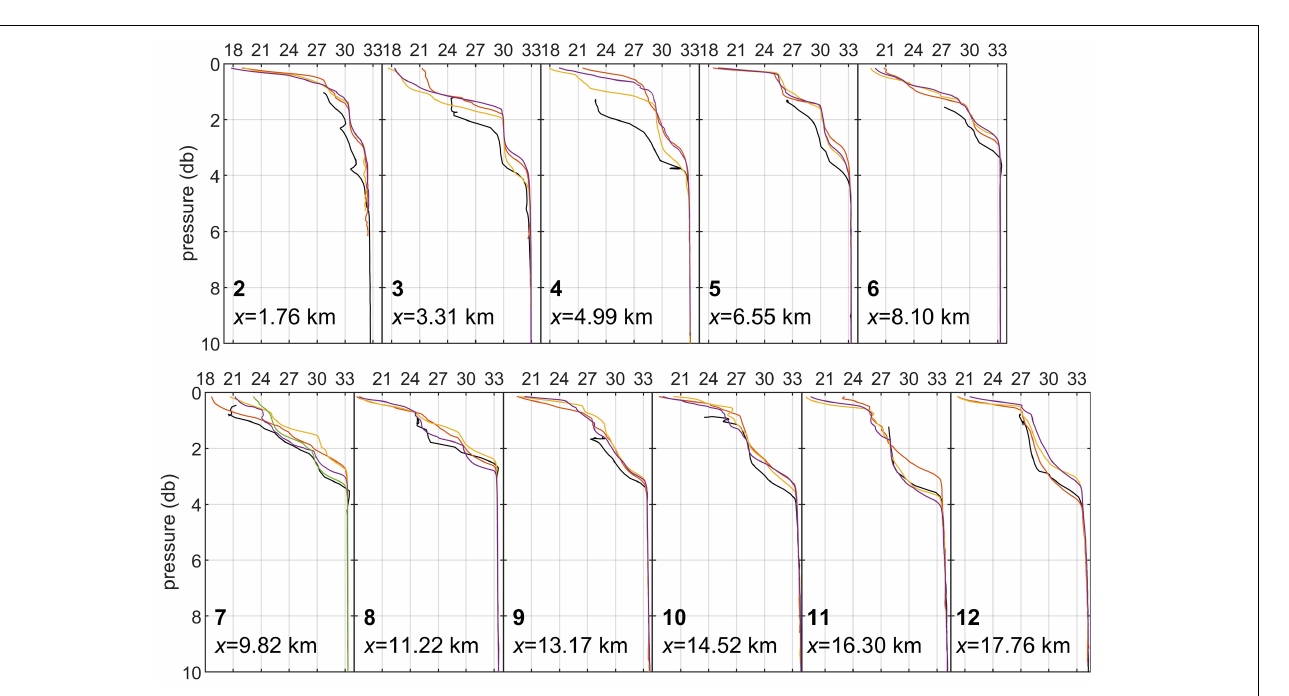
FIGURE 5 | Salinity profiles at stations 2–12: black – CTD casts, in colors – multiple MicroCTD casts. Salinity scale is the same in all panels. Station number and the corresponding transect distance are shown at the bottom of each